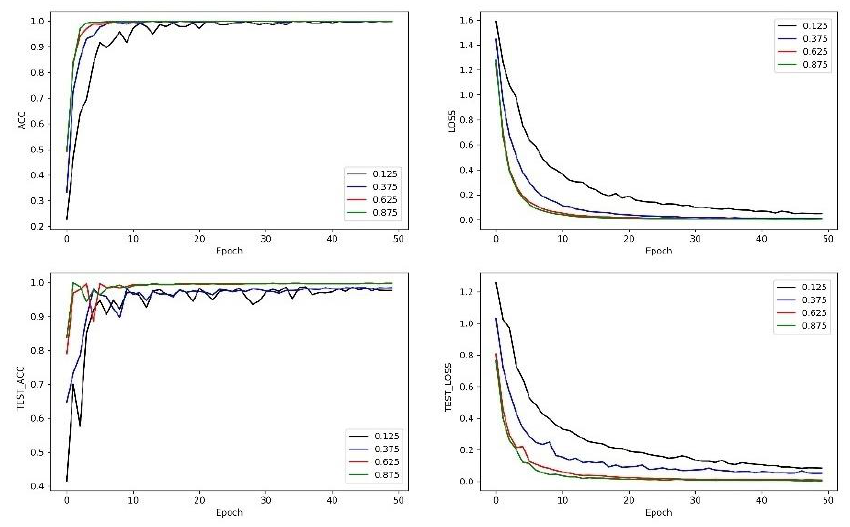
Figure 8. Results of TM1 in different working conditions.